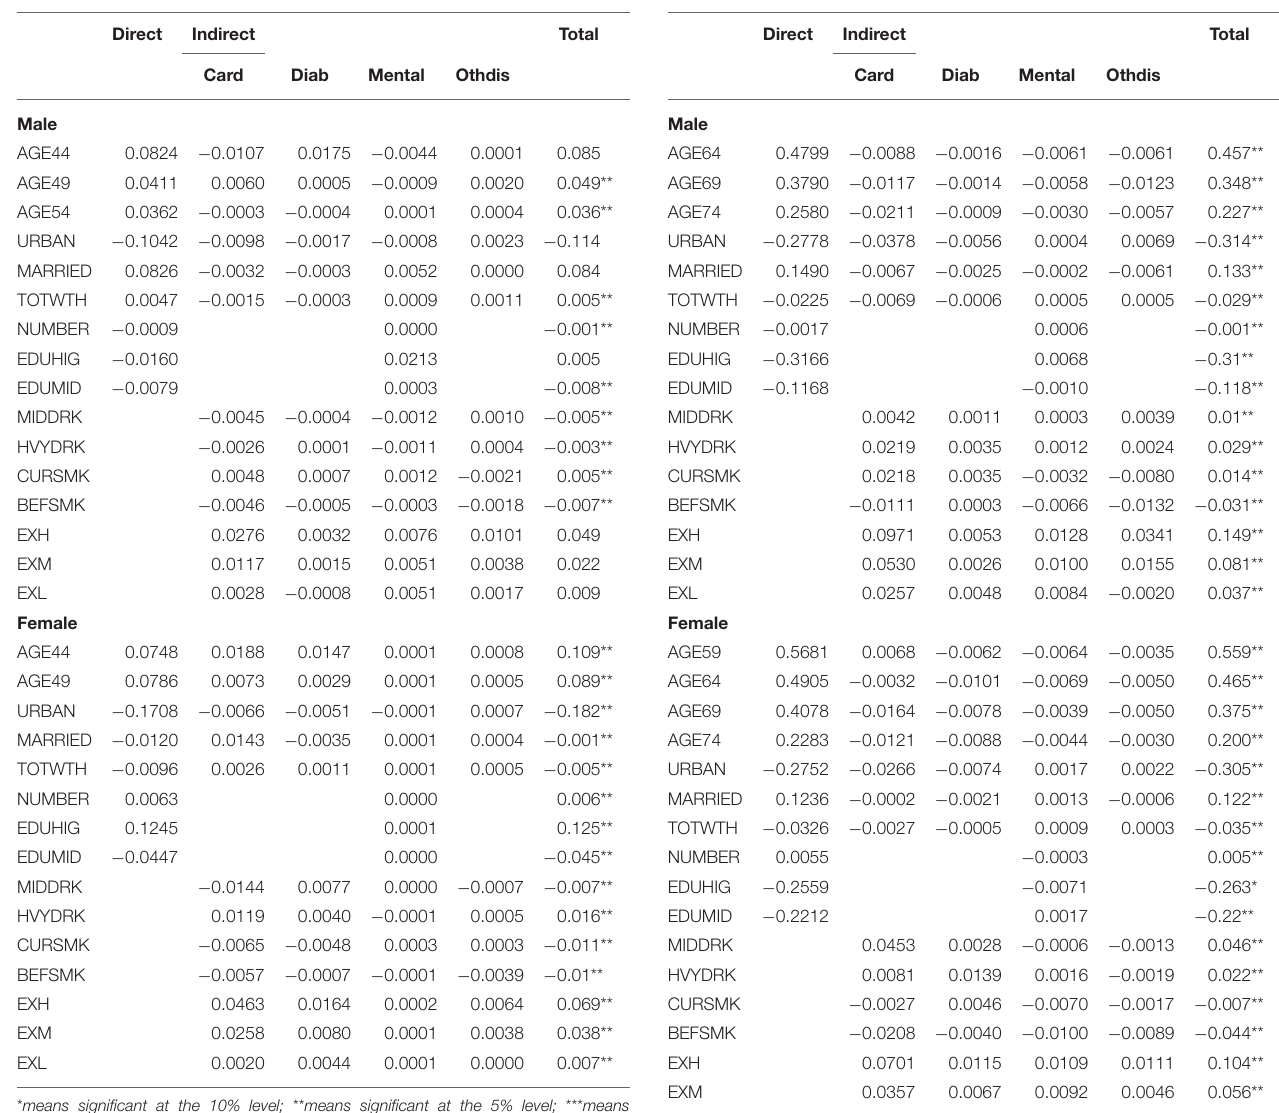
TABLE 7A | Marginal effects on the labor force participation of presenile groups. TABLE 7B | Marginal effects on the labor force participation of senile